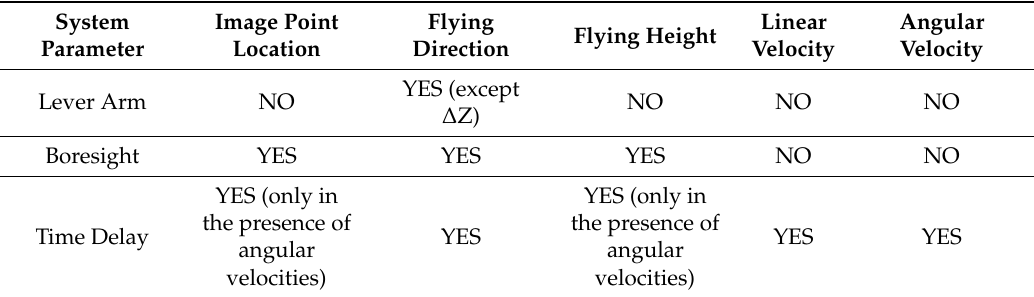
Table 1. Dependency of the bias impact for the system calibration parameters on flight configuration and image point